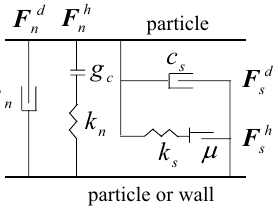
Figure 3. Contact model of particle to particle or